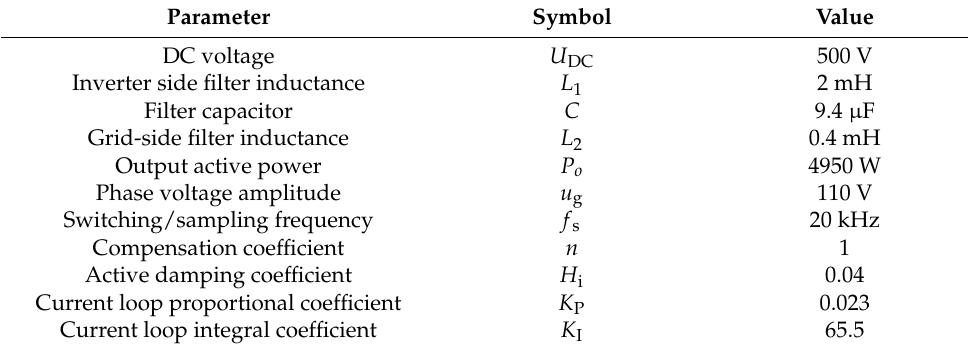
Table 2. System parameters.